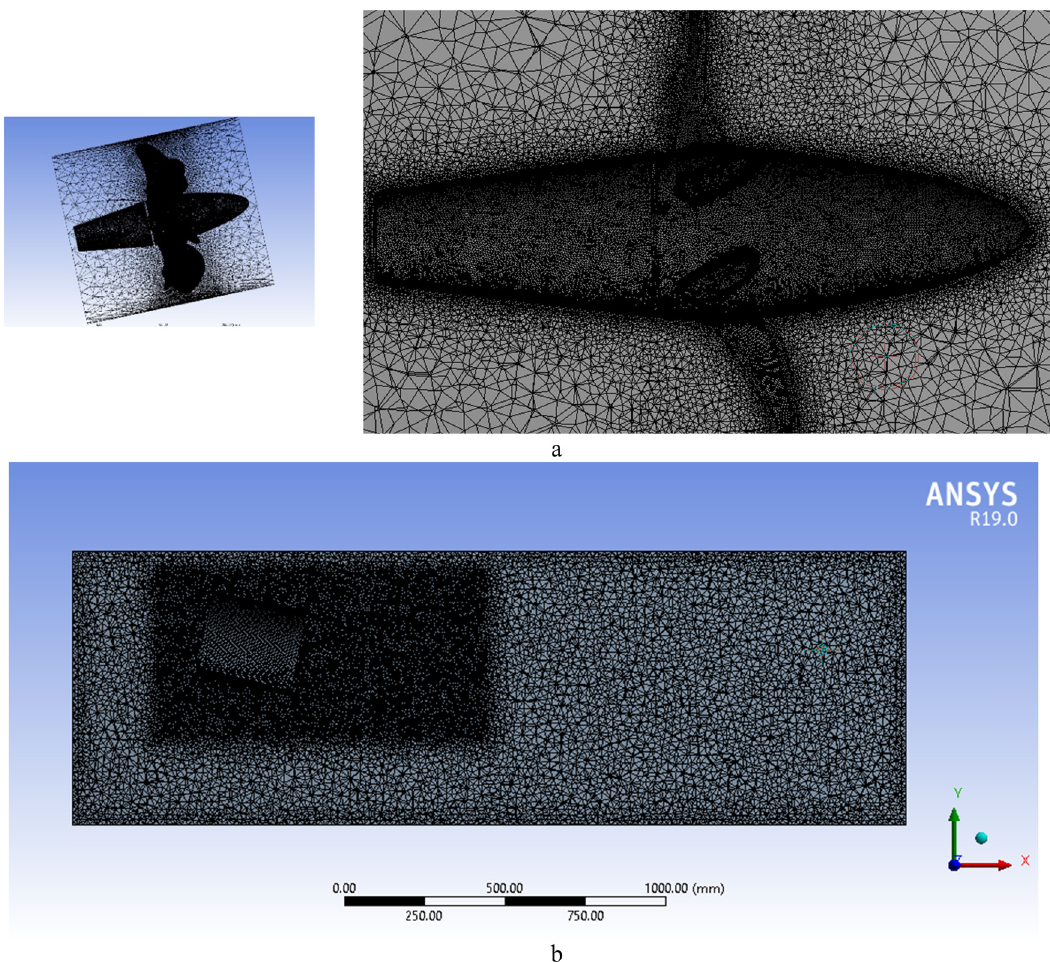
Figure 11: Mesh generated in Ansys program: ( a ) mesh interface for the rotating domain; and ( b ) mesh interface for a fi xed